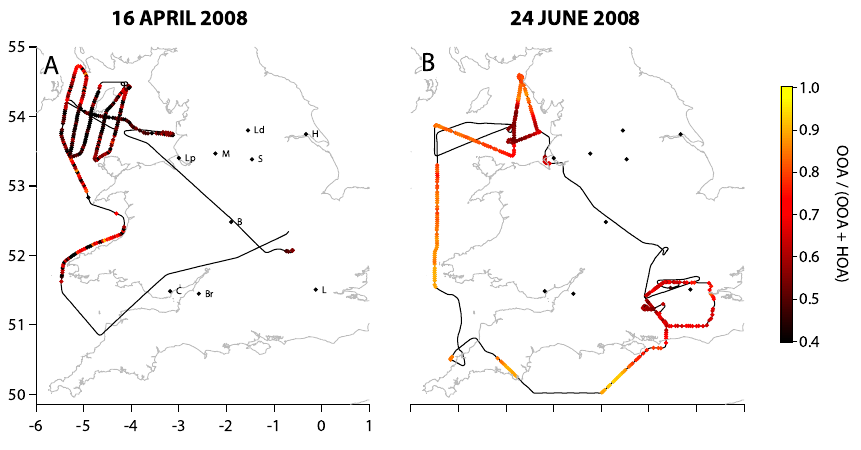
Fig. 4. Maps showing the oxidized organic aerosol (OOA) fraction of organic aerosol (OA) determined from positive matrix factorization of AMS organic mass spectra.